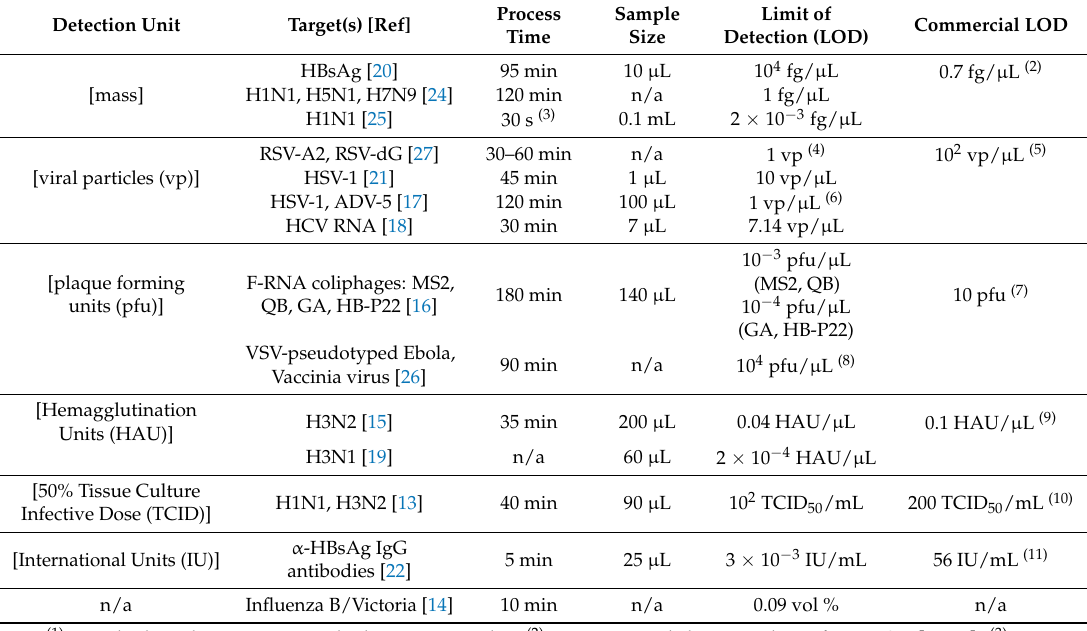
Table 1. Viral detection methods via diffusion, grouped by their reported detection unit (1)